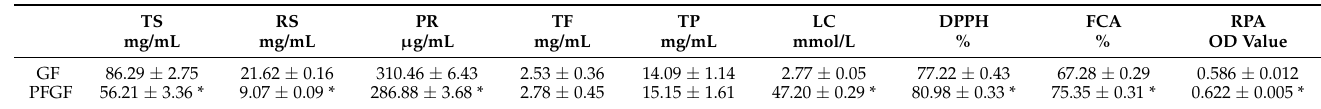
Table 1. The PFGF showed significantly higher antioxidant activities than GF did. Table 1. Composition and antioxidant activities of GF and PFGF; * indicates statistically significant differences ( p <